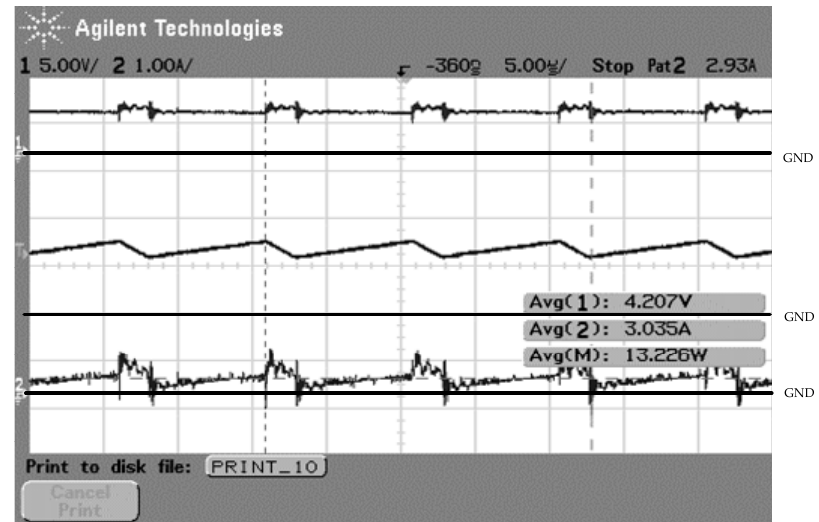
Figure 19. Input characteristics of the proposed boost converter with f s = 100 kHz. ( Top Trace ) Input Voltage; ( Middle Trace ) Input Current; ( Bottom Trace ) Input Power.